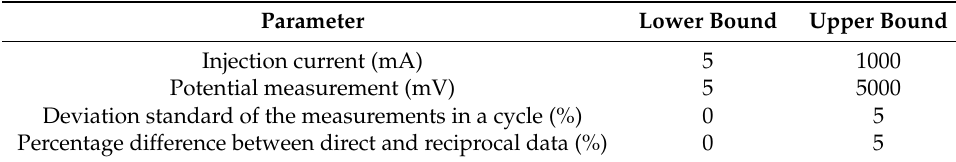
Table 3. Error bounds during ERT data filtering.